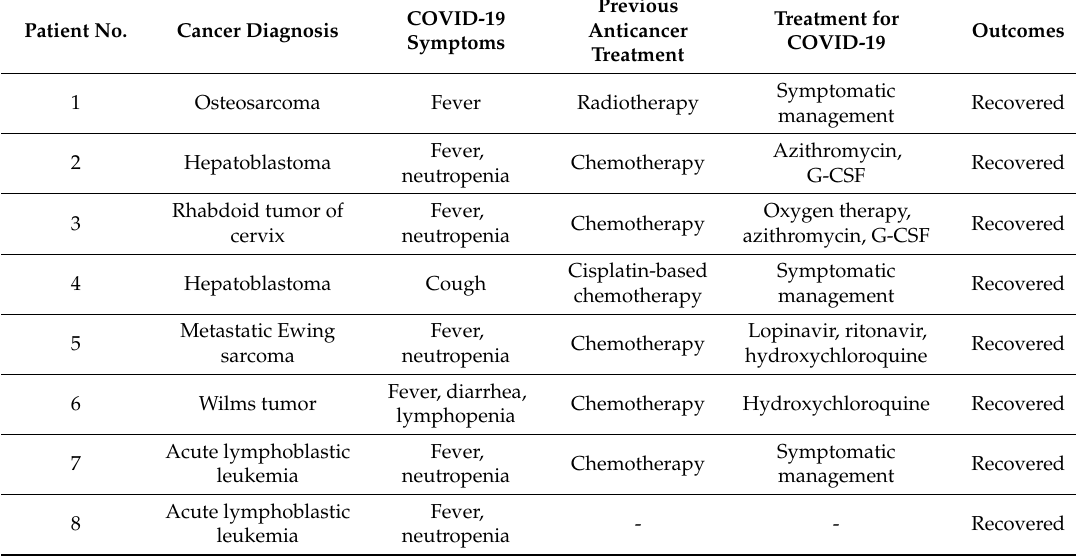
Table 2. The course of coronavirus disease 2019 (COVID-19) in 9 children with cancer. Patient